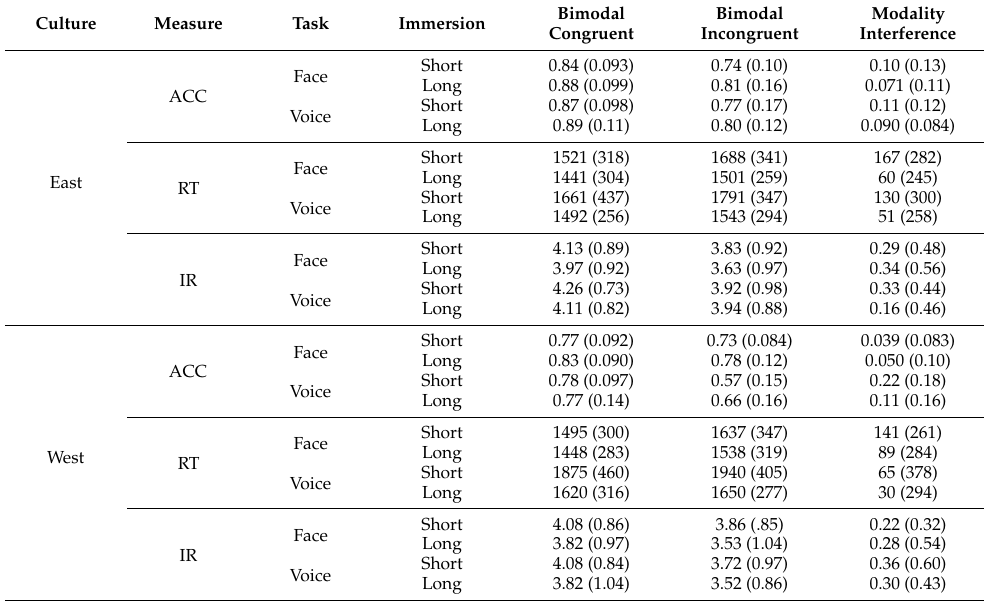
Table 4. Mean accuracy rates (ACC), response times in ms (RT), and intensity ratings (IR) across cultures, tasks, length of immersion, and conditions (standard deviations are in